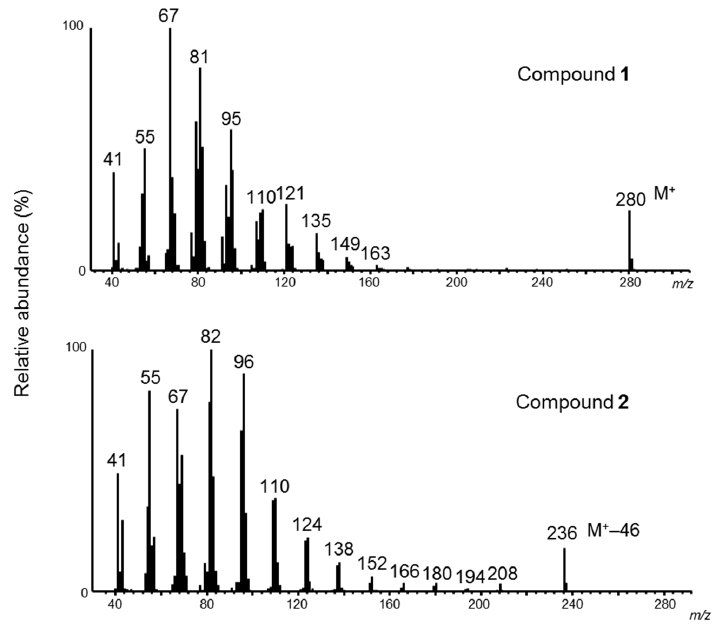
Figure 1. Mass spectra of compounds 1 and 2 in the secretions of Sancassania sp. Sasagawa.